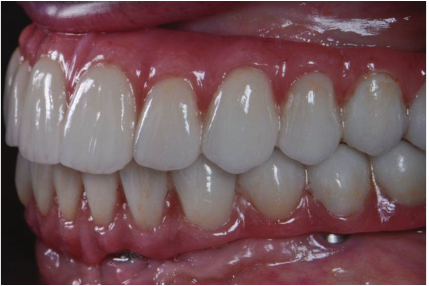
Figure 7: Ceramic application for gingiva colors and teeth ceramic.